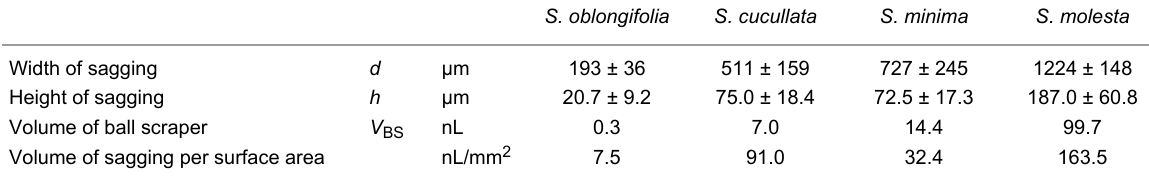
Table 3: Measurement values and volume calculations of the water sagging in between the hairs (mean ± s.d., n = 10).